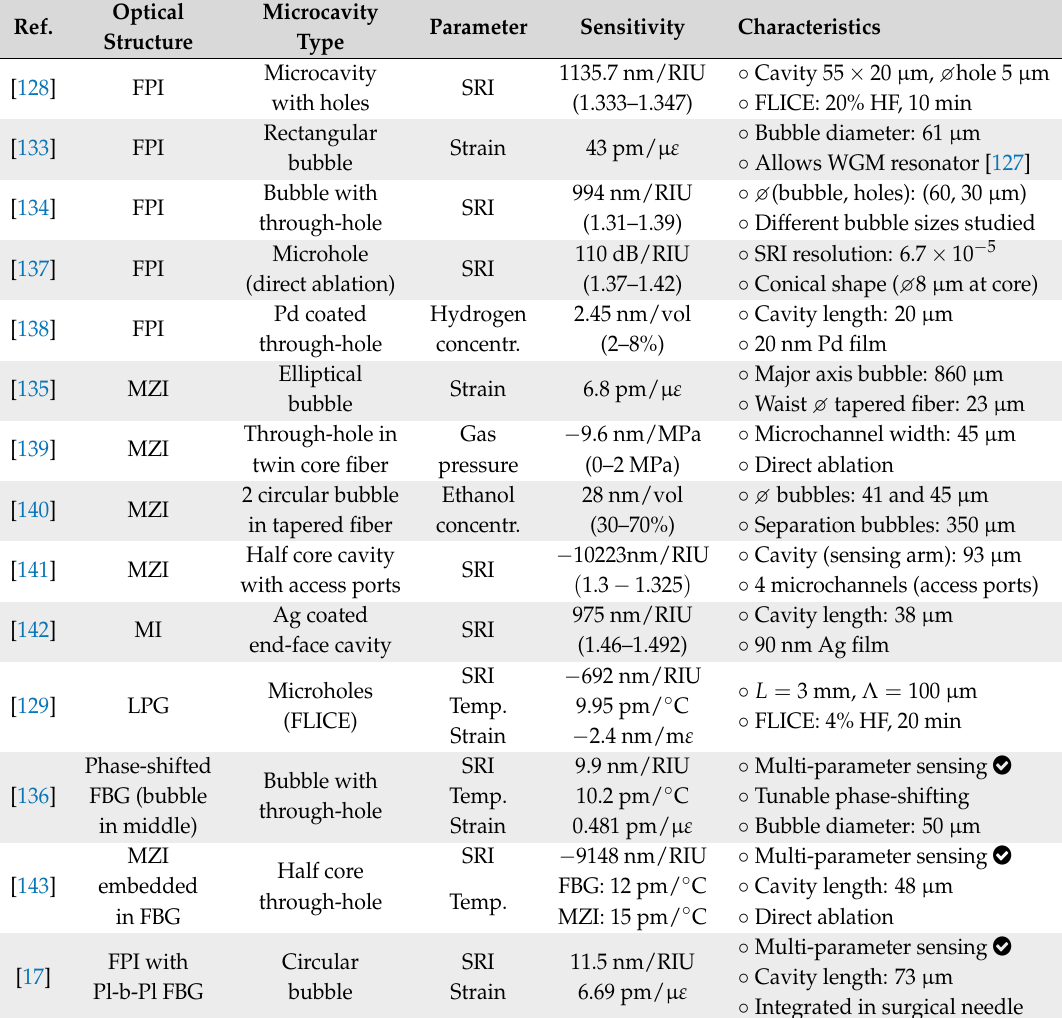
Table 6. Most relevant microcavities-based optical fiber sensors existing in the literature and manufactured using